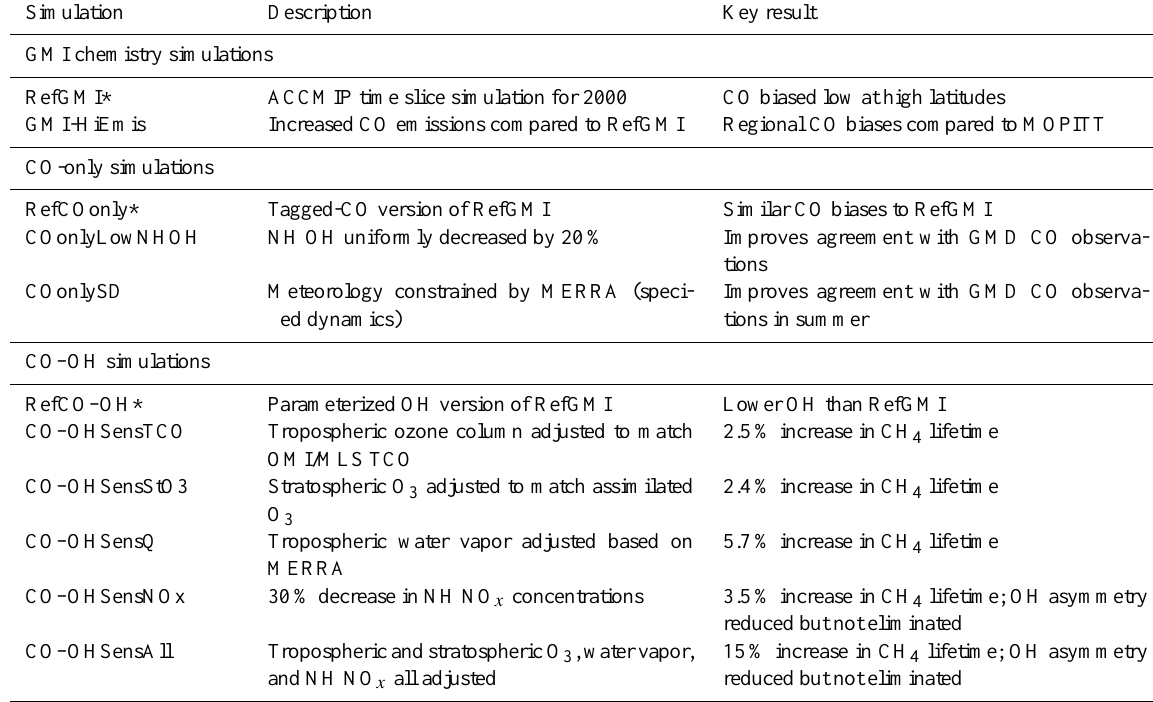
Table 1. Description of reference and sensitivity simulations used in this study with each chemistry